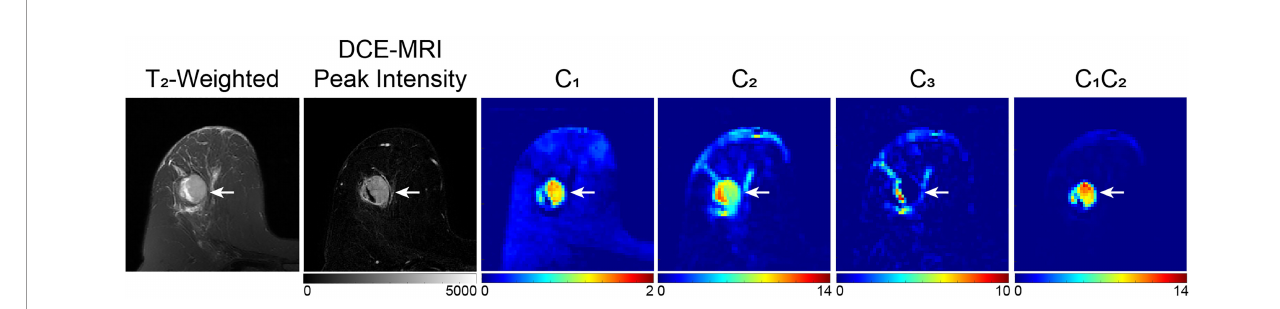
FIGURE 9 | Example of three-compartment RSI analysis in a 49-year-old patient with invasive ductal carcinoma. C 1 , C 2 , and C 3 maps correspond to the slowest, intermediary, and fastest diffusion compartments, respectively. The lesion, indicated by the white arrow, is hypointense on C 1 and C 2 maps compared to surrounding healthy tissue, whereas there is little difference in the C 3 compartment, which is suggested to correspond to vasculature. The product of C 1 and C 2 (C 1 C 2 ) results in the greatest tumor conspicuity. DWI images were acquired at b = 0, 500, 1500, and 4000 s/mm 2 on a 3T scanner, with 50% reduced FOV and without parallel imaging